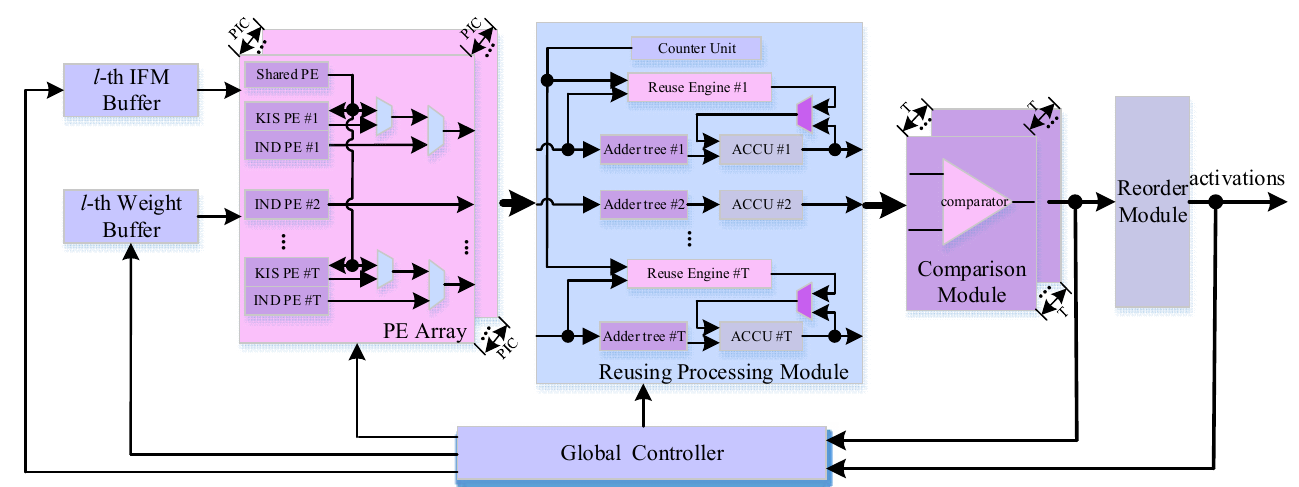
Figure 6. The overall architecture of the proposed efficient accelerator.